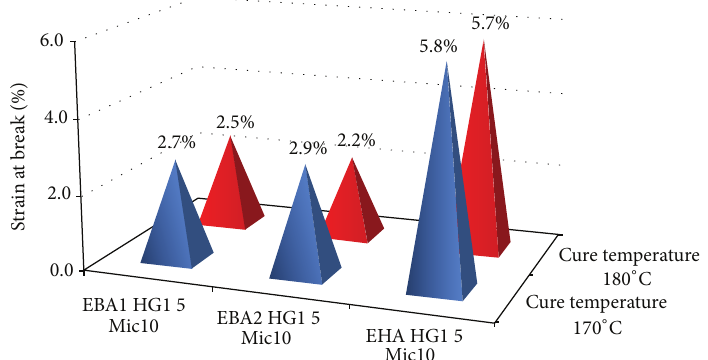
Figure 5: Strain at break of self-healing epoxy formulations at different curing temperature of 170 ∘ C and 180 ∘ C.